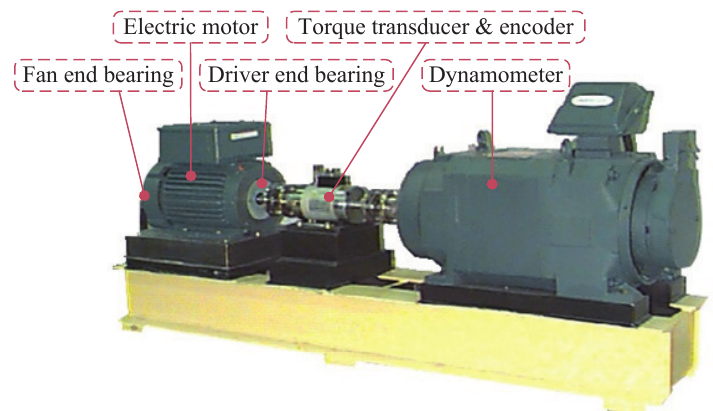
Figure 9. Experimental setup of motor